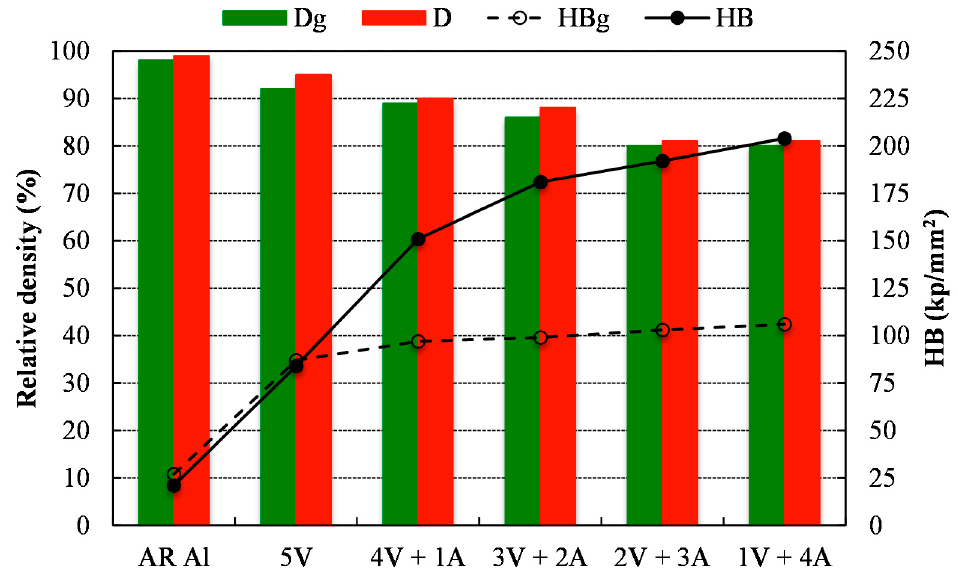
Figure 3. Relative density and hardness, both after pressing (D g and HB g , respectively) and sintering (D and HB, respectively), of the different milled powders.